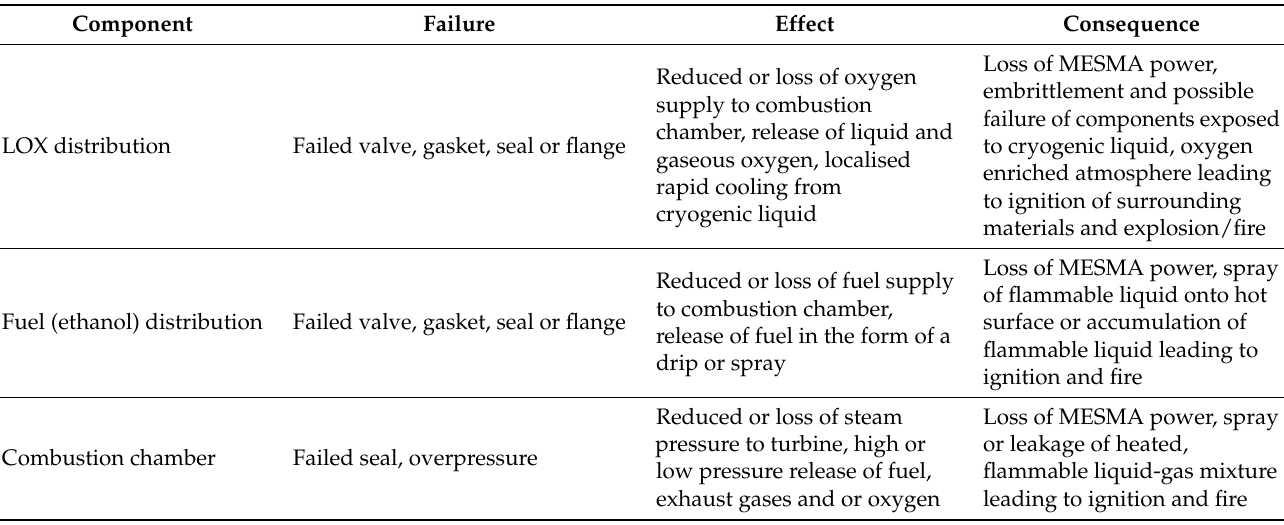
Table 5. MESMA System Failures Leading to